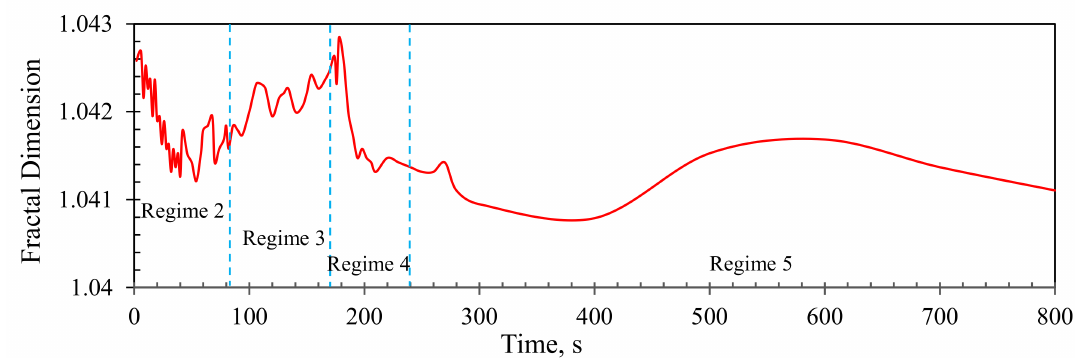
Figure 4. Variations of fractal dimension of viscous fingering.